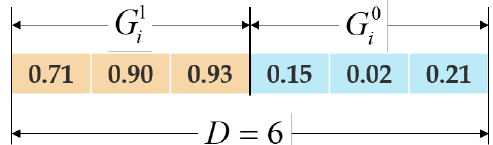
Figure 3. Individual represents the clusters of changed and unchanged classes. G 1 i is the cluster of changed class, and G 0 i is the cluster of the unchanged class.